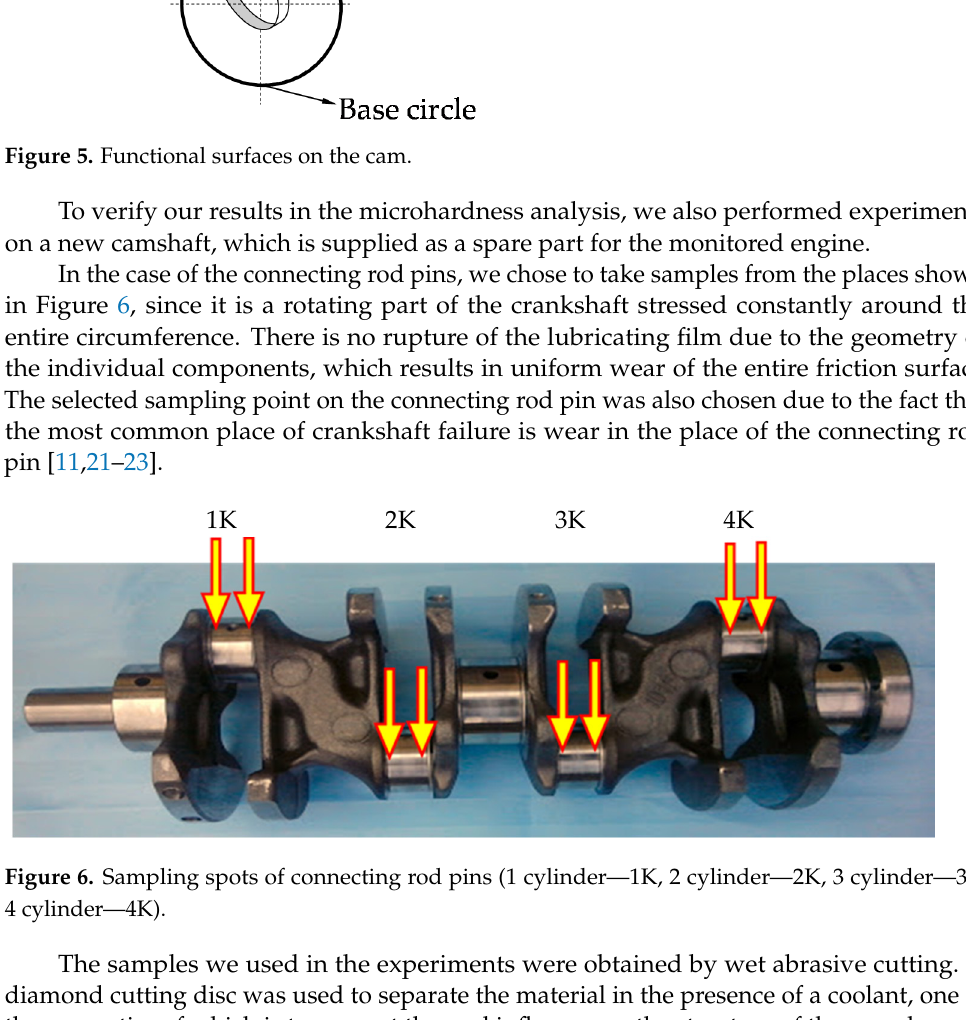
Figure 4. Camshaft sampling spots (I—intake cam, E—exhaust cam).